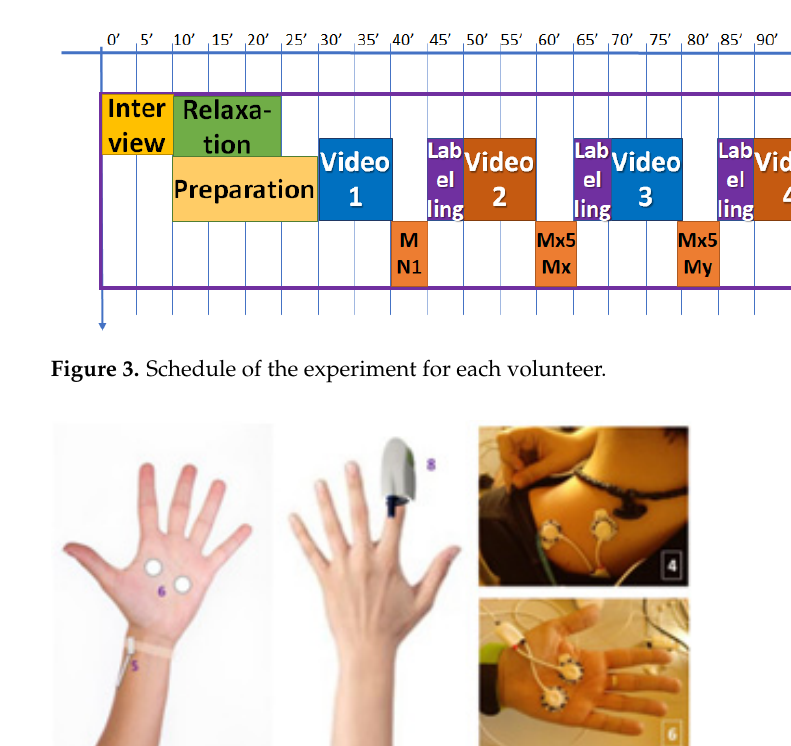
Figure 4. Electrodes and sensors position for experiment.